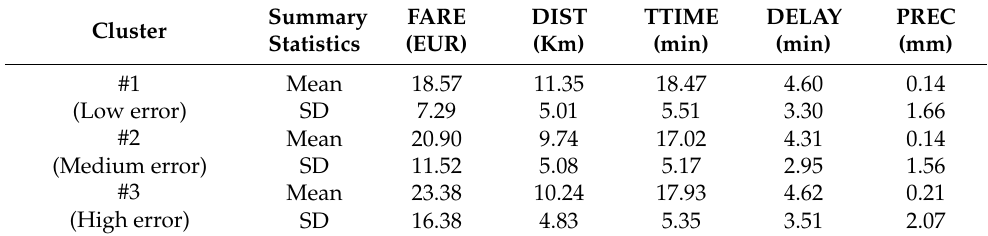
Table 6. Relationship between the continuous variables and the formed clusters. Summary Cluster Statistics